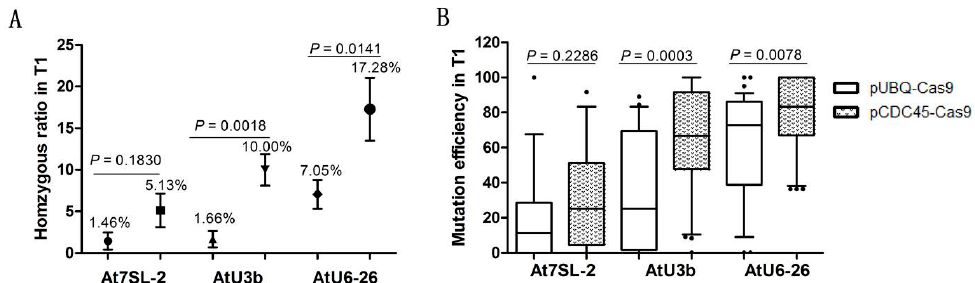
Figure 3. Analysis of mutation frequencies induced by different Pol III promoters. ( A ) Ratio of T1 homozygous mutations for the three Pol III promoters in each of the two multiplex CRISPR/Cas9 systems. ( B ) Mutagenesis efficiency in the T1 generation for the three Pol III promoters in each of the two multiplex CRISPR/Cas9 systems. Data are averages ± SE, Student’s t -test were used to value the data.